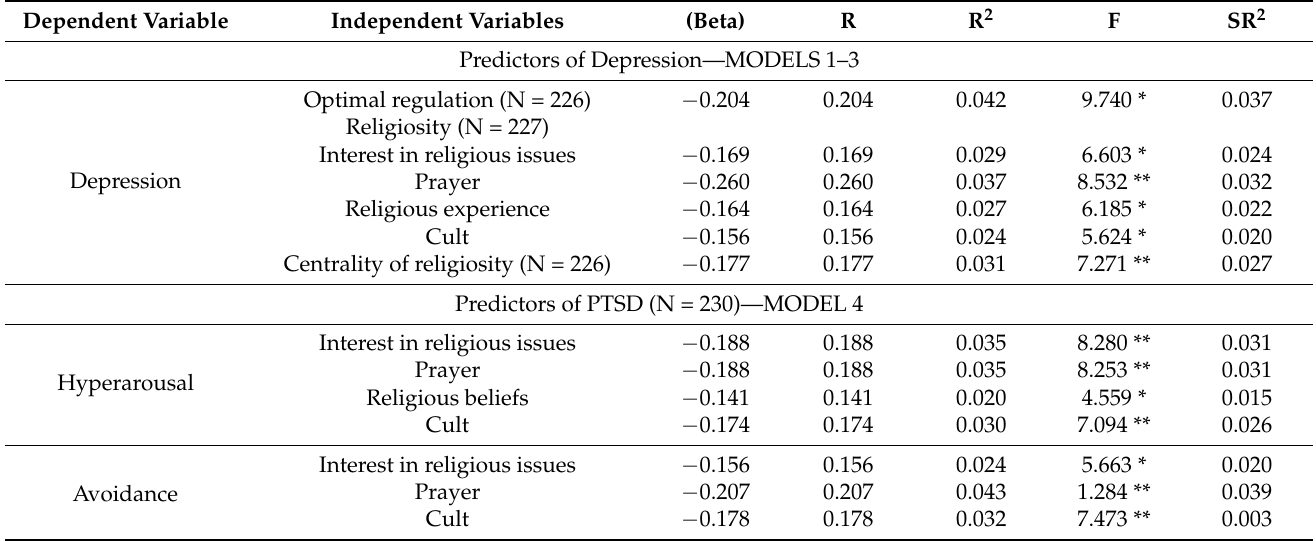
Table 3. Predictors of psychopathological reactions—results of regression